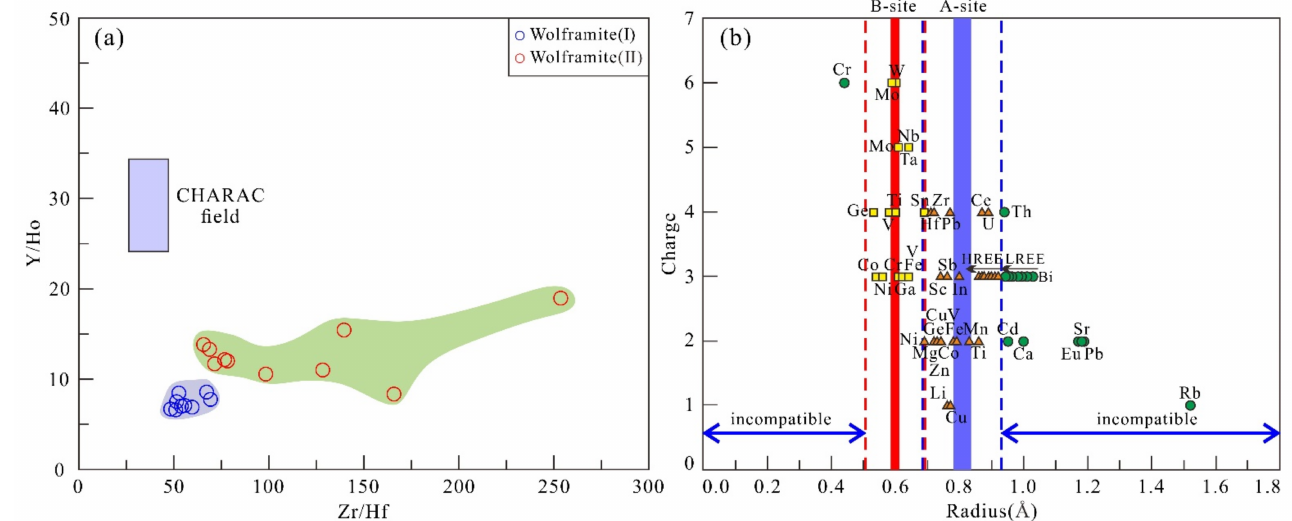
Figure 16. ( a ) Y/Ho versus Zr/Hf ratios in wolframite from the Baishitouwa deposit. The CHARAC field is from [103]. ( b ) Ionic radius versus electric charge diagram for major and trace elements in octahedral co-ordination in wolframite showing the theoretical occupancy of the A- and B- sites (modified from [1]). Dash lines represent the lower and upper limits of 15% relatively to the lattice site radius corresponding to total substitution (Goldschmidt’s rule). Ionic radii data are from